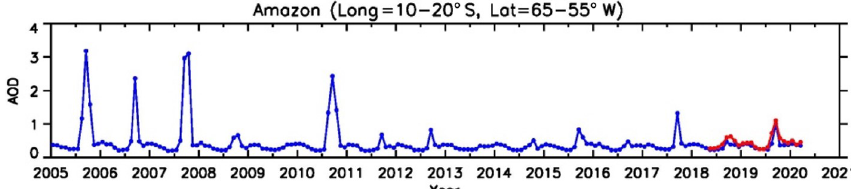
Figure 11. Time series of 388nm AOD over the Amazon Basin from OMI (blue line) and TROPOMI (red line) observations.